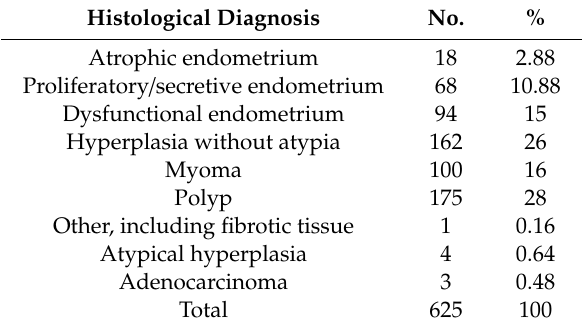
Table 2. Distribution of histological reports.